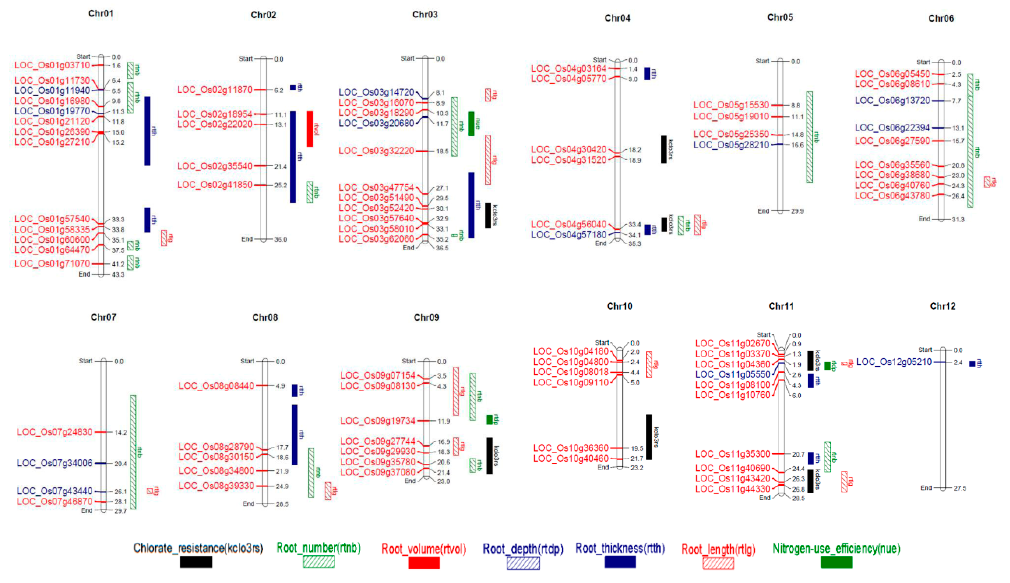
Figure 9. Pokkali-specific low N response DEGs co-localized on chromosomes with chlorate resistance, root development and nitrogen use efficiency (NUE) quantitative trait loci (QTL). Locus names in red font: downregulated, blue font: upregulated. QTLs included were chlorate resistance (kclo3rs): black solid bar; root number (rtnb): green diagonal bar; root volume (rtvol): red solid bar; root depth (rtdp): blue diagonal bar; root thickness (rtth): blue solid bar and root length (rtlg): red diagonal bar.